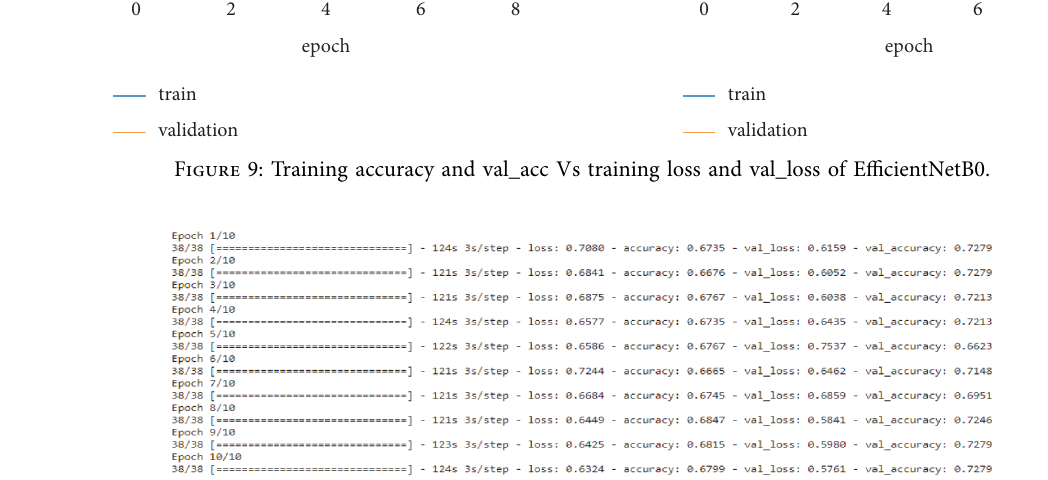
Figure 10: Overall accuracy of ResNet50